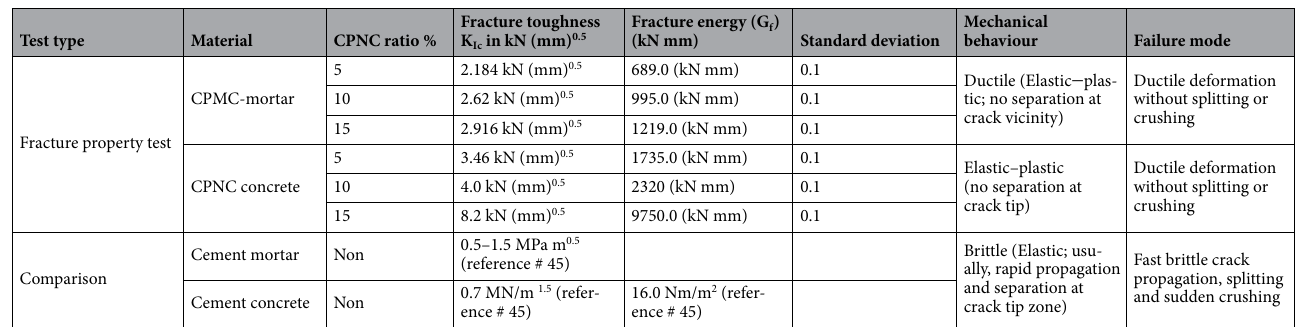
Table 4. Fracture properties of CPNC concrete and CPNC mortar relative to Portland cement materials. The cracking mode found from the CPNC concrete tensile fracture test shows CPNC concrete and CPNC mortar with different CPNC ratios (5%, 10%, and 15% CPNC) relative to Portland cement concrete under 3-point loading for pre-cracked beams with notches; the results are shown in this table and Fig. 4a1–a3,b based on ASTM standards, and they prove that CPNC concrete is ductile without sudden failure or